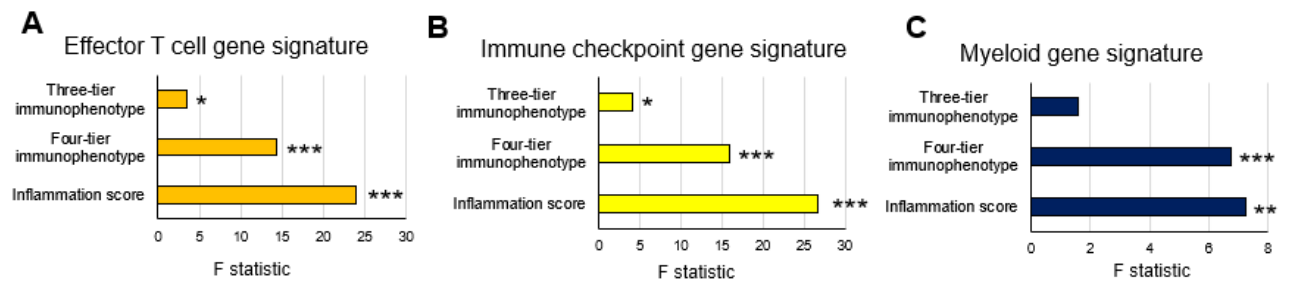
Figure 5. Correlation analysis between three evaluation methods of the tumor immune microenvironment and gene expression signatures in the TCGA cohort: ( A ) effector T-cell gene signature;